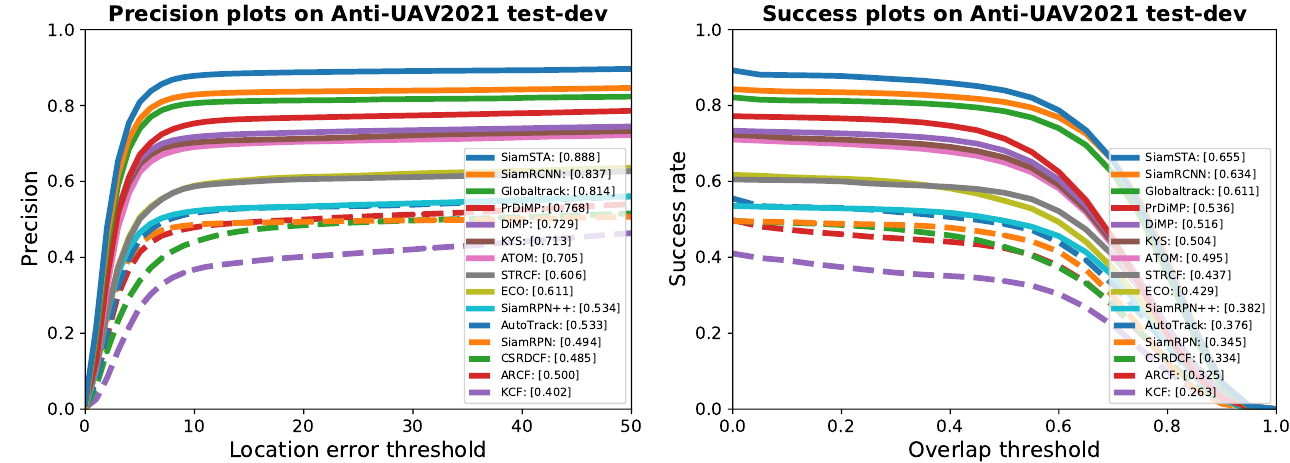
Figure 5. Precision and success plots of our SiamSTA and state-of-the-art trackers on the Anti- UAV2021 test-dev dataset. The mean precision and AUC scores are reported for each tracker. Best viewed in color and